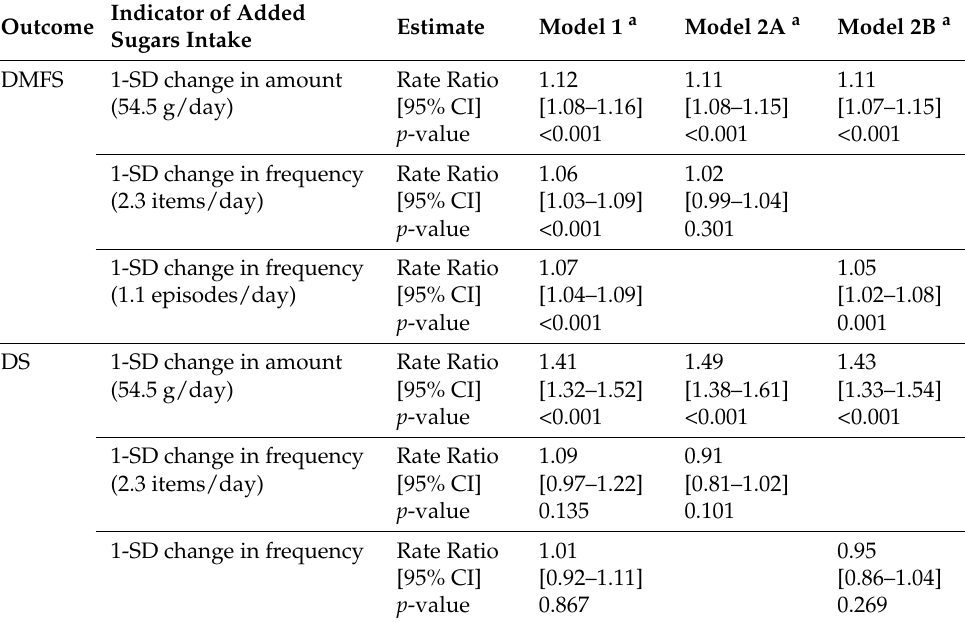
Table 3. Negative binomial regression models for the associations of amount and frequency of added sugars intake with dental caries in US adults ( n = 10,514). Indicator of Added Outcome Sugars